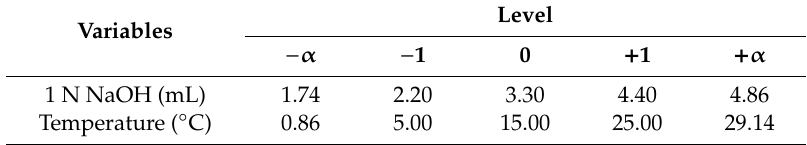
Table 1. Coded experimental level of two variables employed for pectin de-esterification